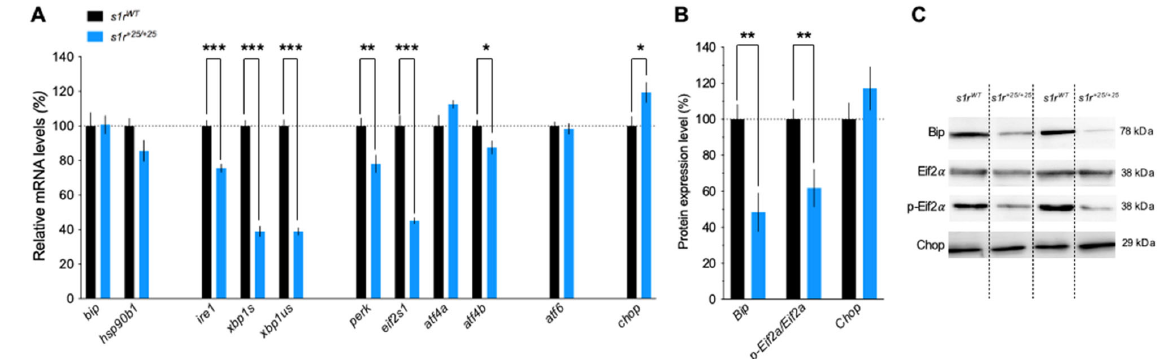
Figure 4. Related mRNA and protein expression levels of ER stress markers in zebrafish larvae in physiological conditions at 5 dpf. ( A ) mRNA levels were analyzed by qPCR in whole larvae. ( B ) Protein contents were analyzed by Western blot. ( C ) Representative Western blots. zeif2 α level and Stain-Free ™ were used as a loading control in qPCR and Western blot analyses, respectively. Data are expressed as mean ± SEM, normalized to s1r WT control level with n = 5–9 in each group. * p < 0.05, ** p < 0.01, *** p < 0.001; unpaired t ‐ test.